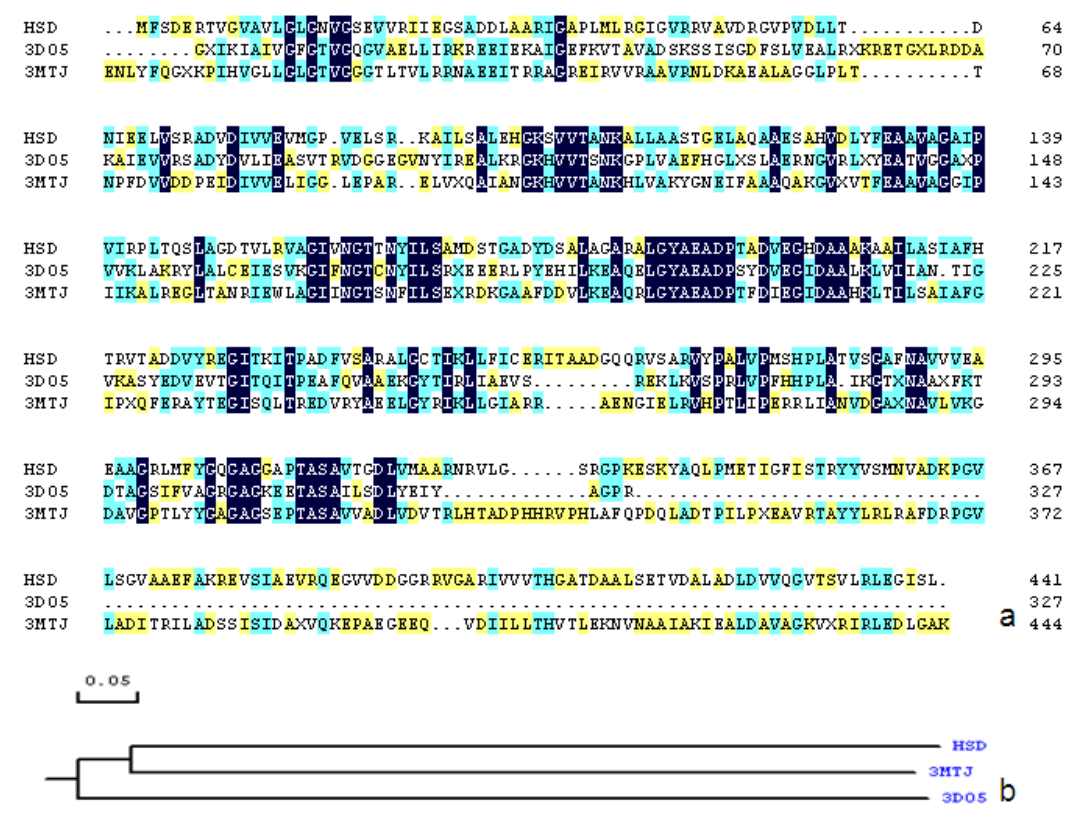
Figure 1. ( a ) Sequence alignment of HSD homologs. 3MTJ (40%); 3DO5 (41%); ( b ) Phylogenetic tree of HSD, 3MTJ, and